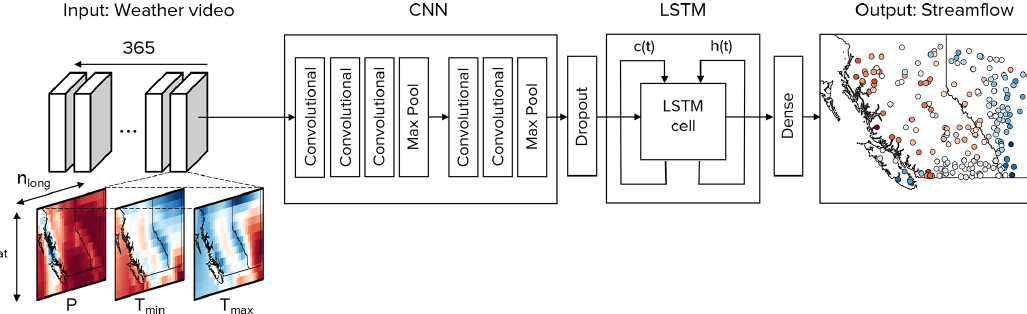
Figure 3. Overview of the model architecture. The model input is a weather video with 365 frames/images, each corresponding to 1d of weather from ERA5 reanalysis in the past year. Each frame in the video has three channels corresponding to precipitation ( P ), maximum temperature ( T max ), and minimum temperature ( T min ). Each channel has dimensions of n lat × n long , where n lat is the number of grid cells in the vertical direction (latitude) and n long is the number of grid cells along the horizontal direction (longitude). Each frame in the weather video is passed through a CNN, and each weather video generates a sequence of 365 feature vectors. A dropout layer is used between the CNN and LSTM for regularization. The sequence of 365 feature vectors is then passed through an LSTM and a dense linear transformation to output the next day of modelled streamflow at N stations (i.e. streamflow at day 366 at N stations). Within the LSTM cell, c(t) is the cell state, and h(t) is the hidden